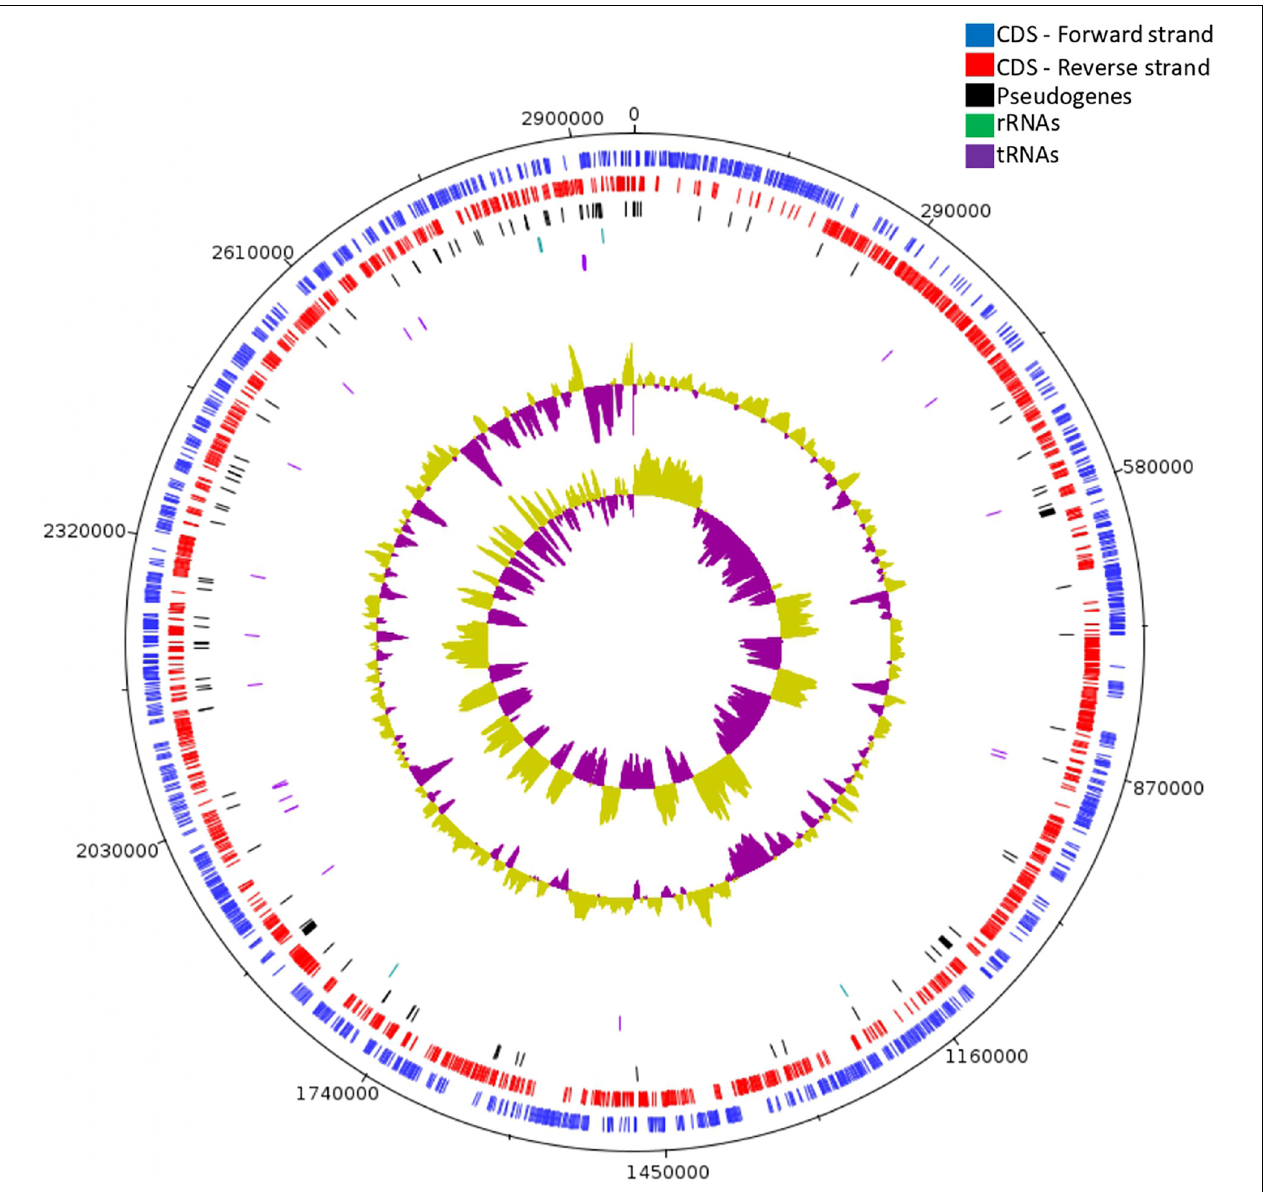
FIGURE 1 | Circular genome map of Lc. paracasei SP5, constructed using Artemis. From outer circle to inner, genomic features are presented as: forward strand CDS (blue), reverse strand CDS (red), pseudogenes (black), rRNA genes (green) tRNA genes (purple), GC content and GC